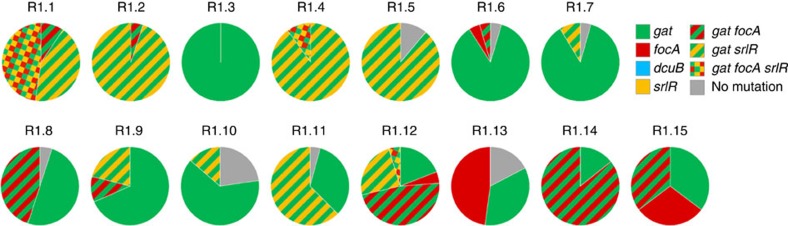
Host genetics influences the genetic basis of E. coli adaptation in the gut.Frequencies of haplotypes in E. coli populations evolved in the gut of Rag2−/− mice for 24 days. Clones (n∼20) isolated from the last day of evolution of lineages R1.1 to R1.15 (Fig. 1b) were screened for the presence of mutations previously identified in WT animals: gat phenotype (green), insertions in the regulatory region of focA (red) and dcuB (blue) and SNPs in the coding region of srlR (orange). Clones in which none of these mutations were found are shown in grey. Clonal interference is detected by the competition between clones carrying different beneficial mutations (stripes of different colours represent double mutants and clones carrying three mutations are shown as a checkered pattern).